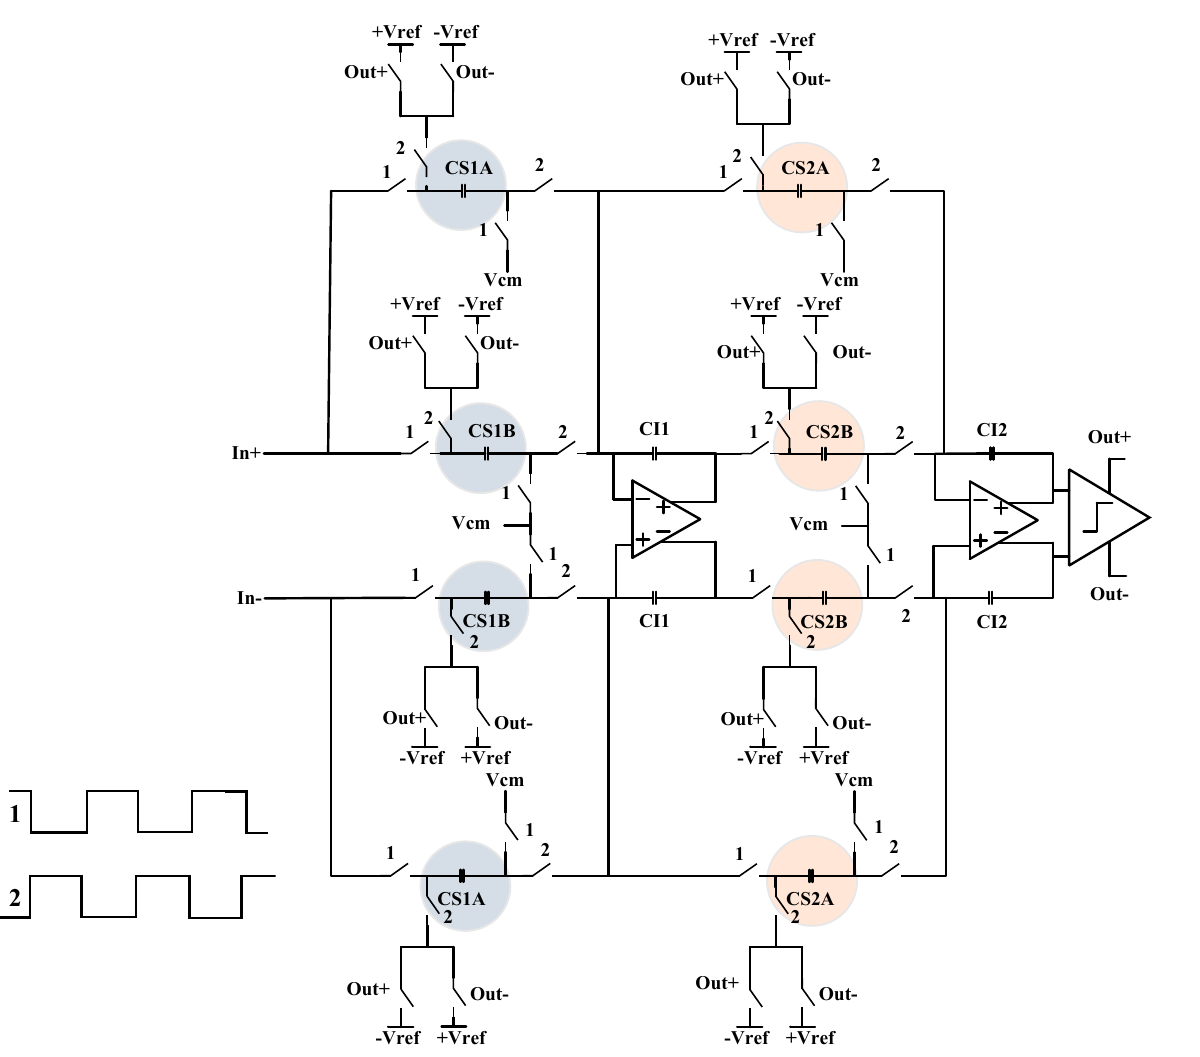
Figure 4. The proposed double sampling sigma–delta modulator for hearing aid applications. Table 2. Sampling and integrator capacitors of the proposed ∆Σ